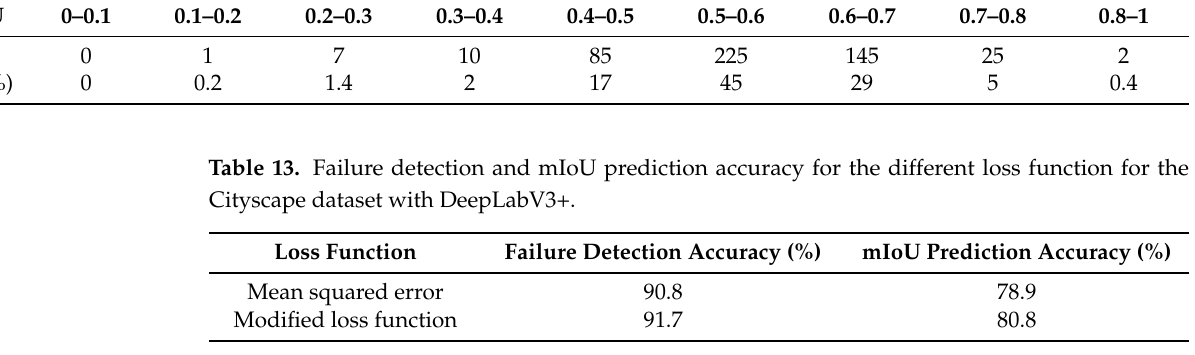
Table 12. Distribution of the ground truth (GT) mean intersection of union (mIoU) generated by DeepLabV3+. GT mIoU 0–0.1